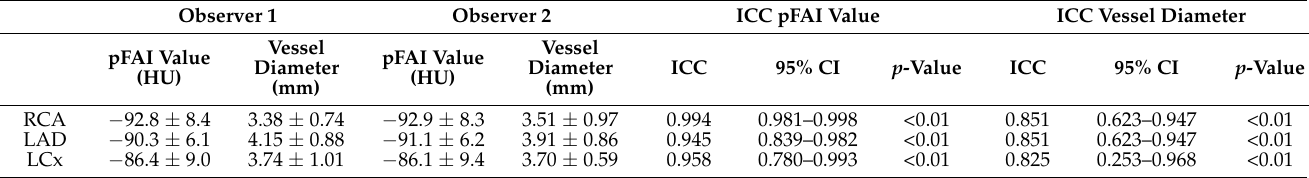
Table 2. Mean pFAI values and vessel diameters of the three major coronary arteries.